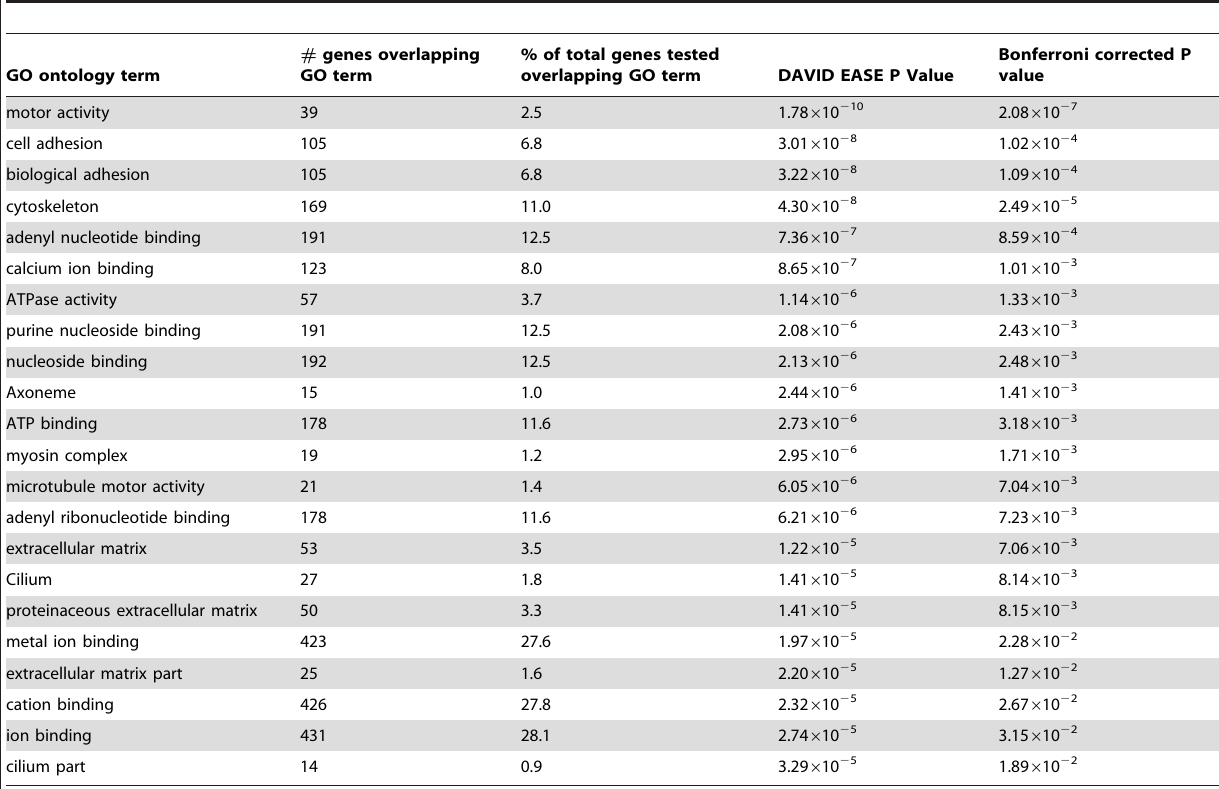
Table 1. Gene Ontology (GO) terms reaching Bonferroni corrected significance for enrichment amongst the 1533 genes harbouring novel putatively functional variants in the resistant smokers, using DAVID.